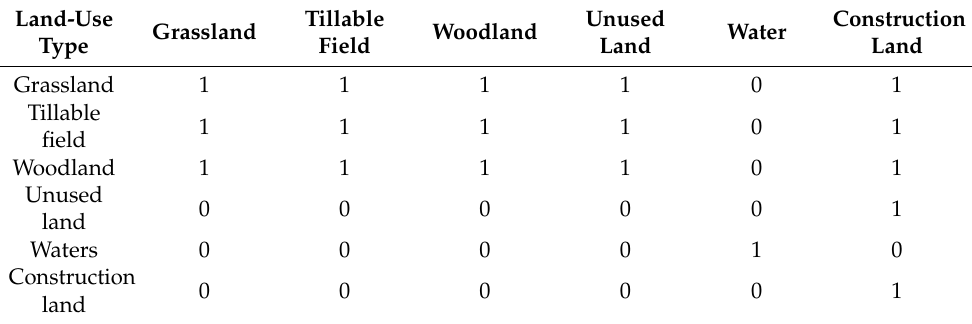
Table 2. Convertibility between different land-use